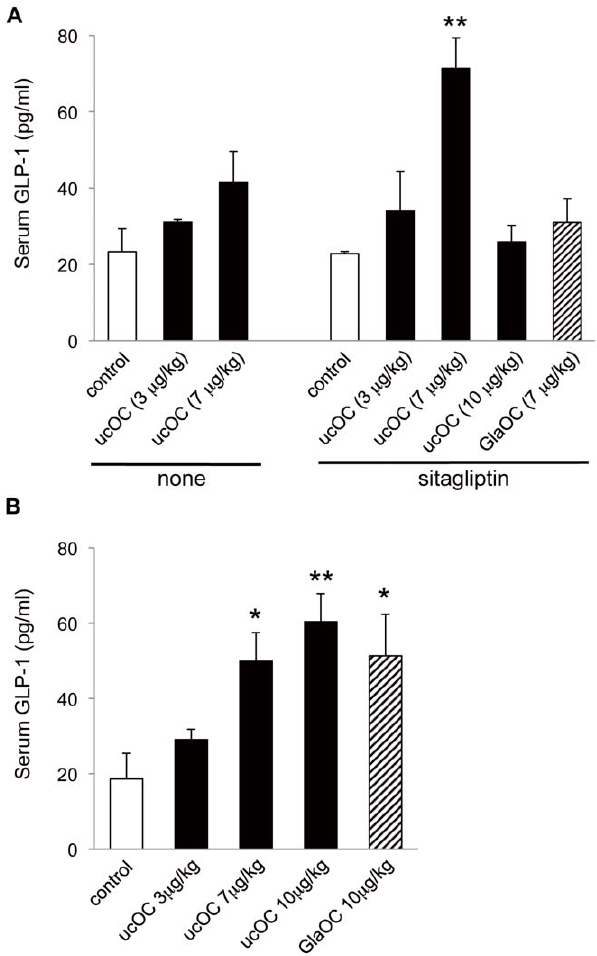
Figure 3. Effect of intraperitoneal or oral administration of OC on serum GLP-1 concentration. ( A ) Mice were deprived of food for 5 h and then injected intraperitoneally with saline (control) or the indicated doses of recombinant ucOC, of GlaOC. Blood was collected 20 min later for determination of the serum concentration of GLP-1. Part of mice was orally administered with sitagliptin (1 m g/kg) 30 min before injection of OC. ( B ) Mice deprived of food for 5 h were treated orally with saline (control) or the indicated doses of ucOC or GlaOC. Blood samples collected 20 min later were assayed for serum GLP-1 concentration. All data are means 6 SEM for five to seven mice. * P , 0.05, ** P , 0.01 versus control (Student’s t test).